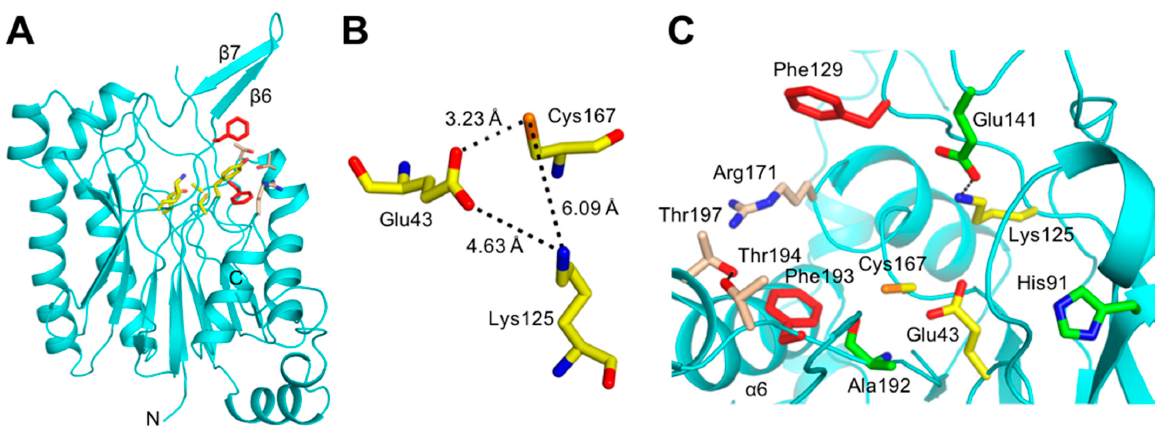
Figure 2. KlNit2 active site. ( A ) Monomeric structure including the active site. ( B ) The catalytic triad of the active site with distances shown between the key catalytic atoms. ( C ) The key residues of the active site. The catalytic triad (Glu43–Lys125– Cys167) is shown in yellow. The residues (Arg171, Thr194, and Thr197) that immobilize the α -carboxyl are shown in the color wheat. The residues (Phe129 and Phe193) that maintain a hydrophobic environment are shown in red. Figures were generated by the graphics program PyMOL (Schrödinger Inc., New York, NY, USA).